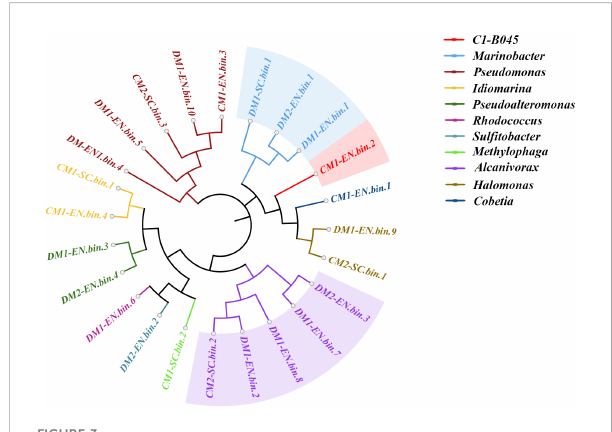
FIGURE 3 Maximum likelihood phylogenomic tree of the 24 bins reconstructed from seven metagenomic datasets derived from the MCH-consuming cultures. The bins of the genus Alcanivorax are highlighted in light purple; the bins of the genus Marinobacter are highlighted in light blue; the bin of genus C1-B045 is highlighted in light